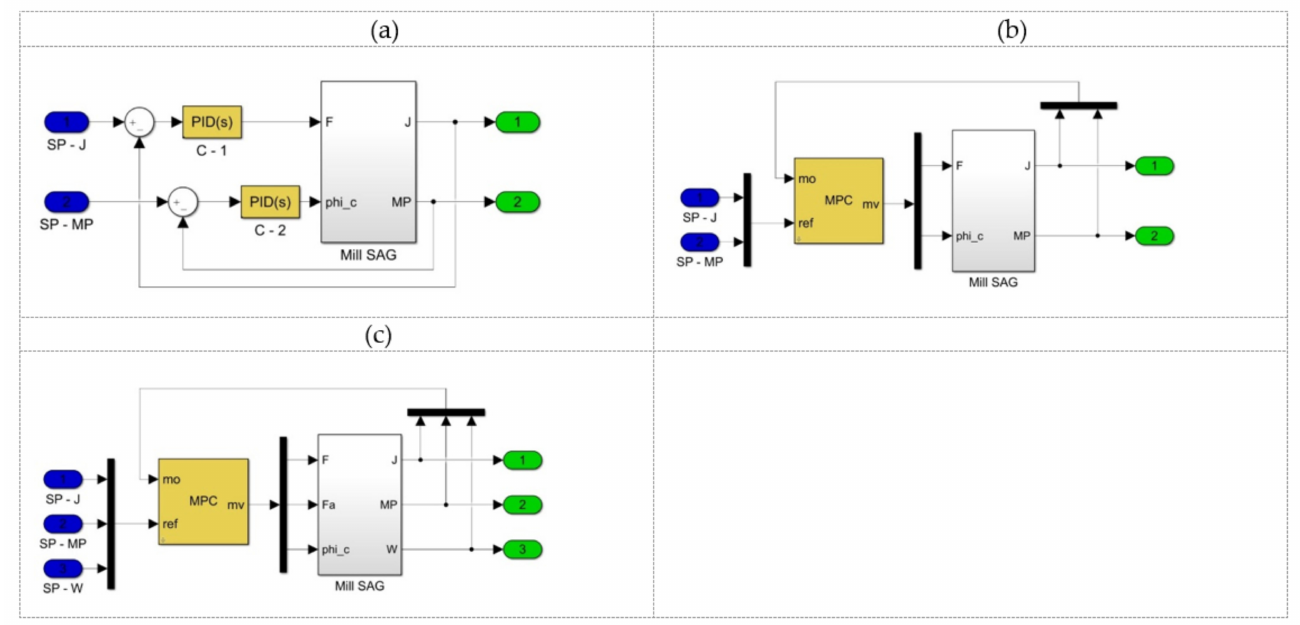
Figure 6. Control systems for SAG mill: ( a ) 2 × 2 PID control, ( b ) 2 × 2 MPC, ( c ) 3 × 3 MPC. Step 4. Closed-loop